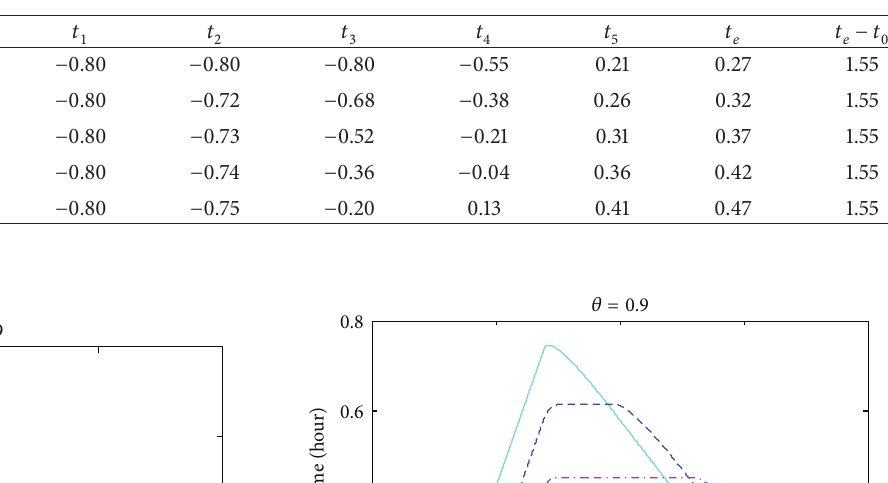
Table 2: The influence of parameter 𝛿 on the mean trip cost and the watershed time instants.